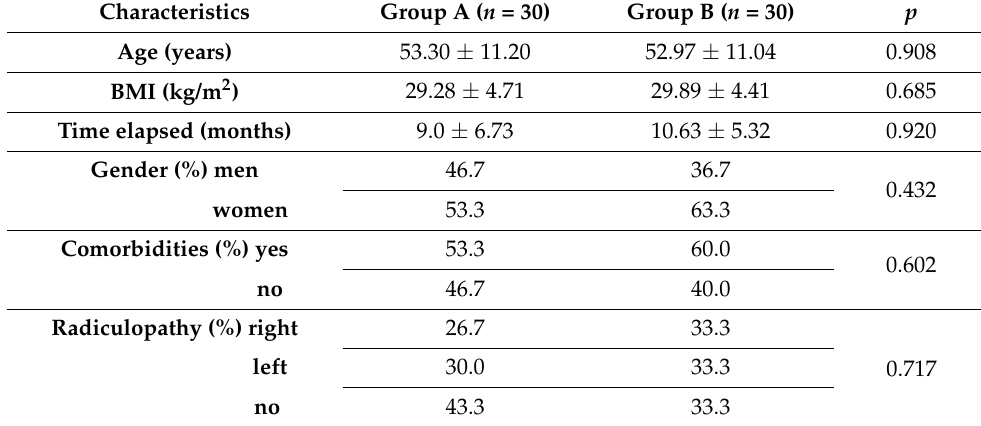
Table 1. Subjects’ demographic characteristics (mean ± SD/%), time from diagnosis to first treatment (mean ± SD) and presence of radiculopathy (%) ( n =